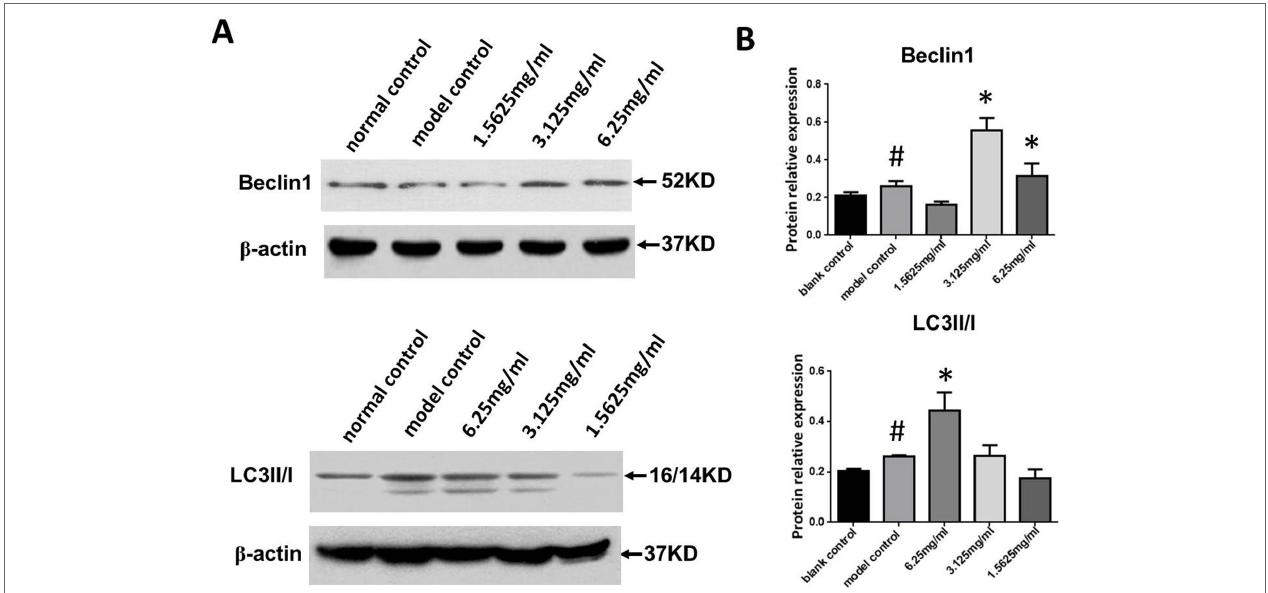
FIGURE 6 | Effects of SYDC on autophagy. (A) Representative images of Western blot showing Beclin-1 expression and the LC3II/I ratio in RAW264.7 cells in the different groups. (B) Quantitation of Beclin-1 expression and LC3II/I ratio in RAW264.7 cells in different groups. GAPDH was used as a loading control. # P < 0.01 versus blank control group alone; * P < 0.01 vs. model control group alone, SYDC-H, high-SYDC (6.25 mg/ml), SYDC-M, middle-SYDC (3.125 mg/ml), and SYDC-L, low-SYDC (1.5625 mg/ml) (n =